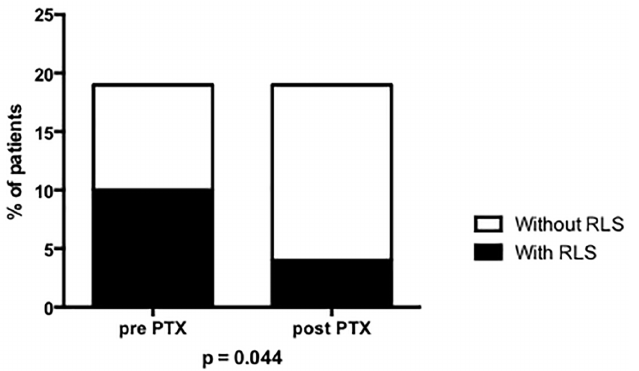
Fig 1. Prevalence of restless leg syndrome (RLS), pre- and post-Figure 1. Pparathyroidectomy.